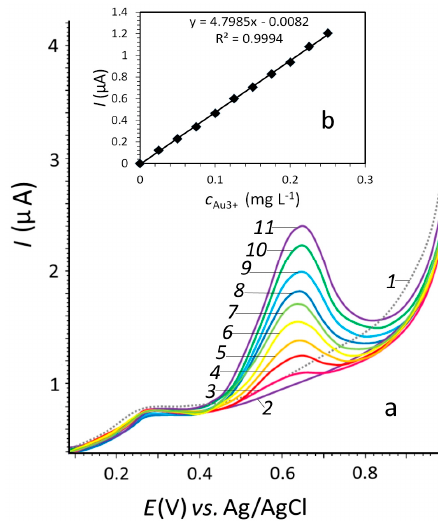
Figure 5. Anodic current–voltage curves ( a ) and calibration dependences ( b ) of gold determination from the unmodified GE surface by SV. Experimental conditions: medium of 1 mol L − 1 HCl, E e = − 0.7 V, t e = 120 s, v = 0.06 V s − 1 ; c Au3+ (mg L − 1 ): (1) 0, (2) 0.025, (3) 0.05, (4) 0.075, (5) 0.1, (6) 0.125, (7) 0.15, (8) 0.175, (9) 0.2, (10) 0.225, and (11) 0.25.